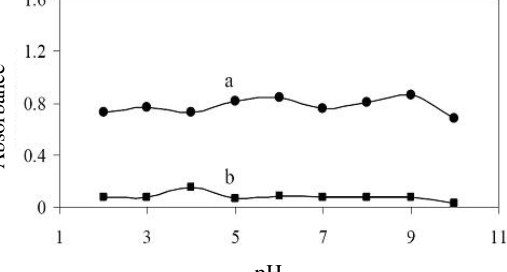
Figure 2. Effect of pH on the maximum absorption spectra of (a) naphazoline and (b) antazoline. Conditions: Britton Robinson buffer (0.01 M), naphazoline 10 µ mol L -1 , antazoline 10 µ mol L